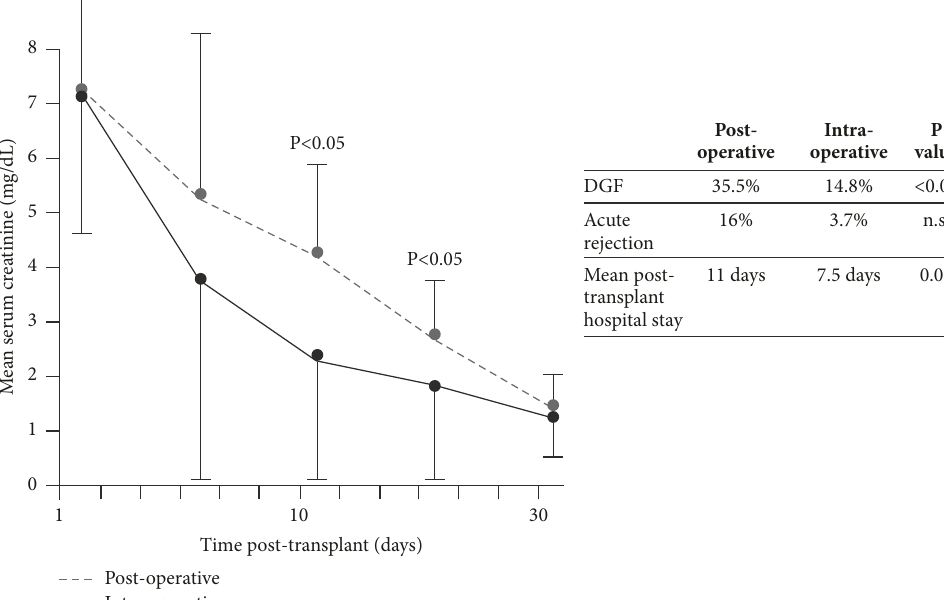
Figure1:Serumcreatininetoday30aftertransplantinkidneytransplantrecipientsrandomizedtostartrabbitantithymocyteglobulin(rATG) intraoperatively (n=27) or postoperatively (approximately 6 hours after reperfusion, n=31) [41]. The total dose of rATG was 3–6 mg/kg in both groups. Maintenance immunosuppression comprised calcineurin inhibitor therapy (started based on renal function), mycophenolate mofetil (MMF), and steroids. DGF, delayed graft